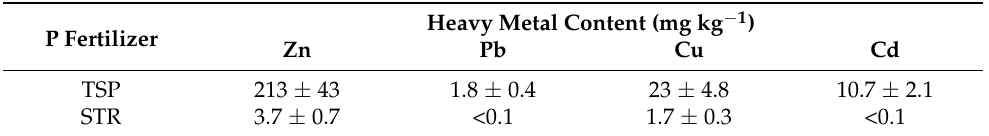
Table 1. Selected heavy metal contents in TSP and STR fertilizers. Results given as a mean ± standard deviation (database of own